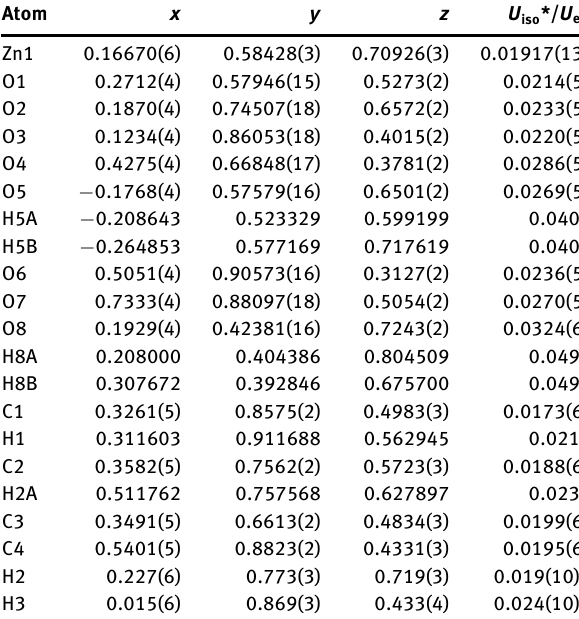
Table 2: Fractional atomic coordinates and isotropic or equivalent isotropic displacement parameters (Å 2